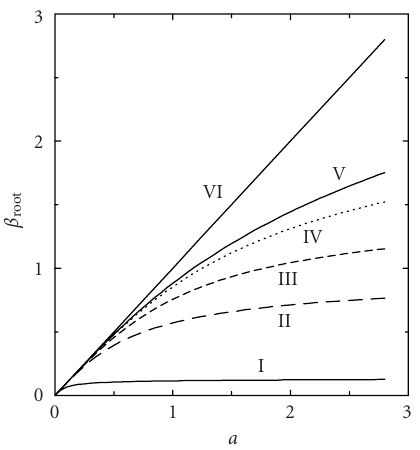
Figure 4.10. The variation of β root as a function of the parameter a for positive values of ν . The exact solution for λ = − 1 and x 0 = 0 . 0. Curve I: ν = 0 . 995, curve II: ν = 0 . 75, curve III: ν = 0 . 40, curve IV: ν = 0 . 1, and curve V: ν = 0 . 0. Curve VI: the solid curve is the straight line β